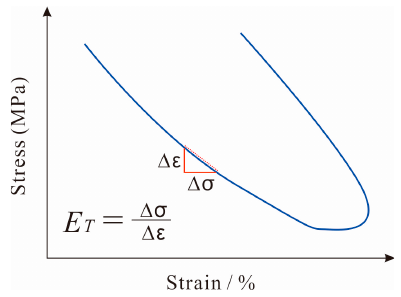
Figure 8. Schematic diagram of tangential modulus.